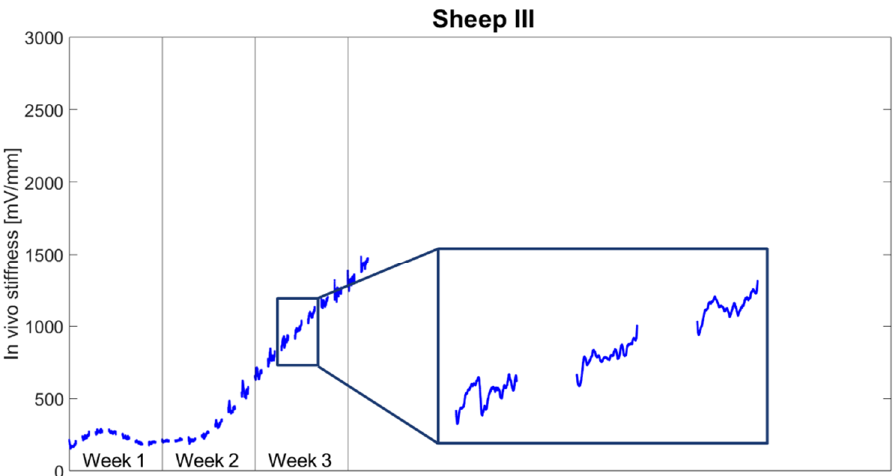
Figure 8. Continuous measurements of the tissue stiffness for Sheep III. Each data point represents one cycle; therefore, each segment shows measurements from 9.00 am to 9.00 pm.